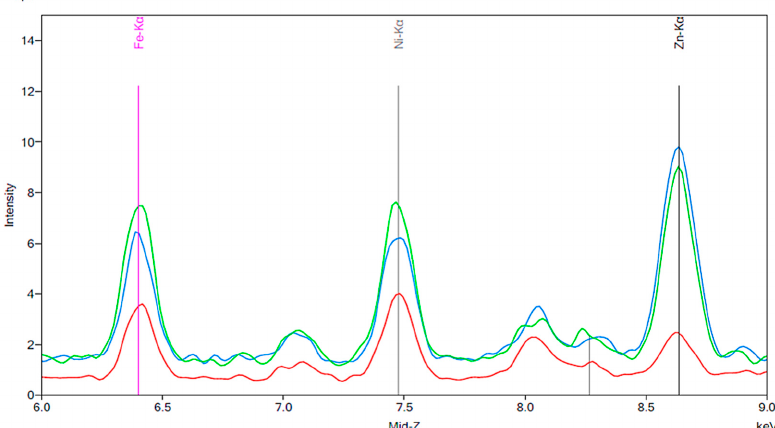
Figure 11. The results of the same tooth brushing experiment as described for Figure 10 used for teeth exposed to coffee. The red peaks indicate the new artificial tooth. The green peaks show the artificial tooth exposed to coffee for 24 h. The blue peaks represent the coffee exposed tooth following 30 s of brushing.